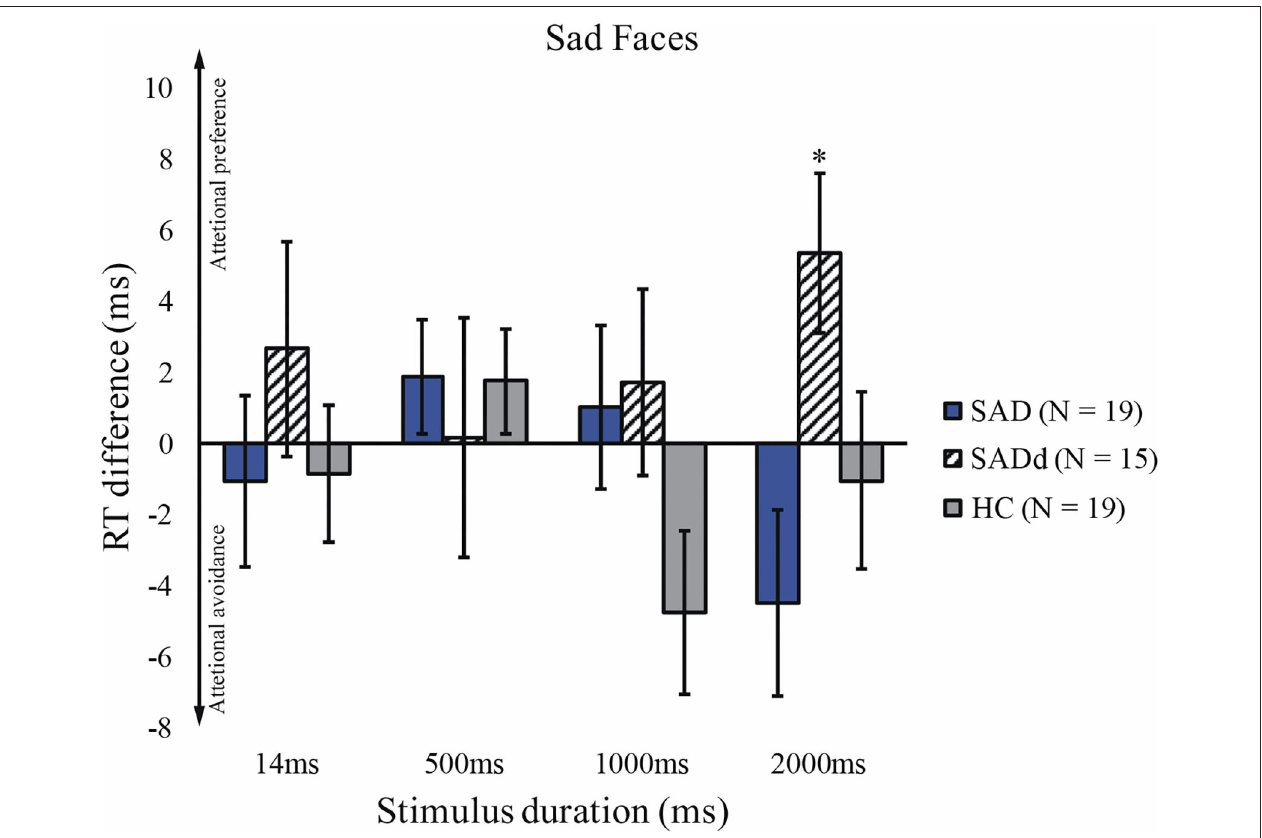
FIGURE 4 | Reaction time differences across groups and stimulus durations for sad